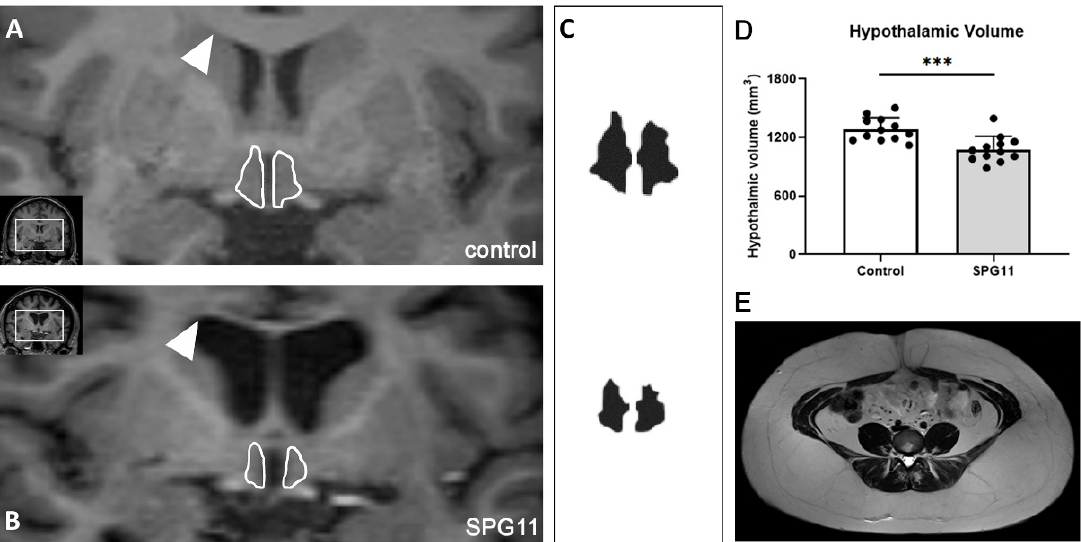
Figure 5. Reduced hypothalamic volume in SPG11. Representative images of hypothalamic volumetry with the MRIcloud software package in a control ( A ) and SPG11 patient ( B ). Arrowheads indicate the ventral border of the corpus callosum showing significant atrophy in SPG11. Outlines of the hypothalamus are in white lines, and 3D segmentation extracted from MRIcloud are shown in ( C ). ( D ) Quantification of hypothalamic volume in SPG11 and matched controls (n = 12). Bars indicate means ± SD. *** p < 0.001. ( E ) T2-weighted axial image of abdominal adipose tissue obtained in a single SPG11 patient.